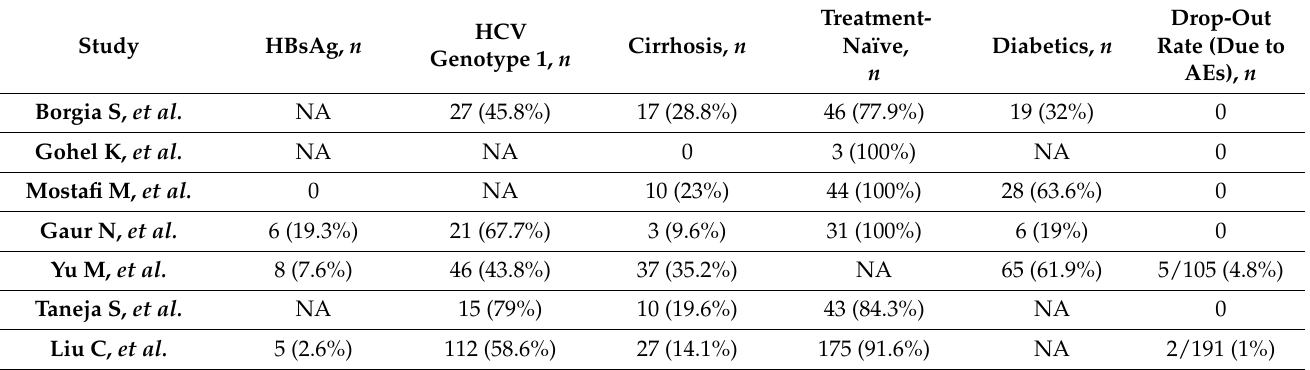
Table 4. Studies on SOF/VEL in advanced CKD: characteristics of study patients (and drop-out rate).